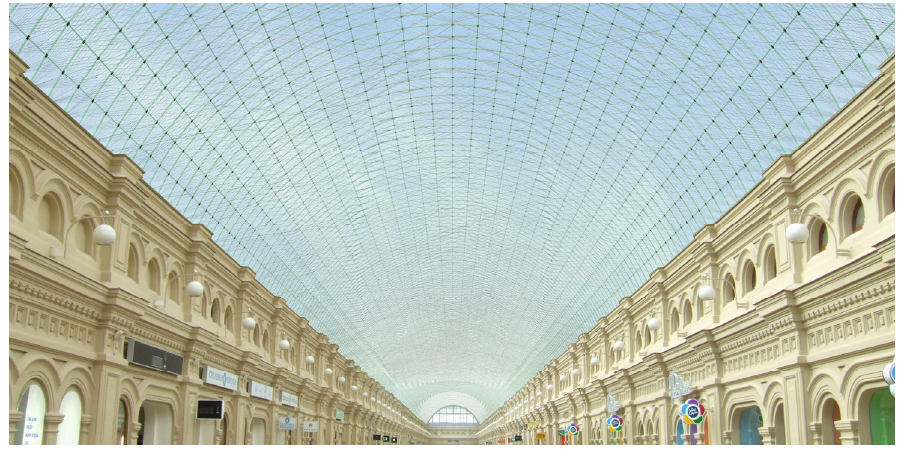
Figure 19: Artist’s impression of the developed system, based on the GUM-facades (14 m